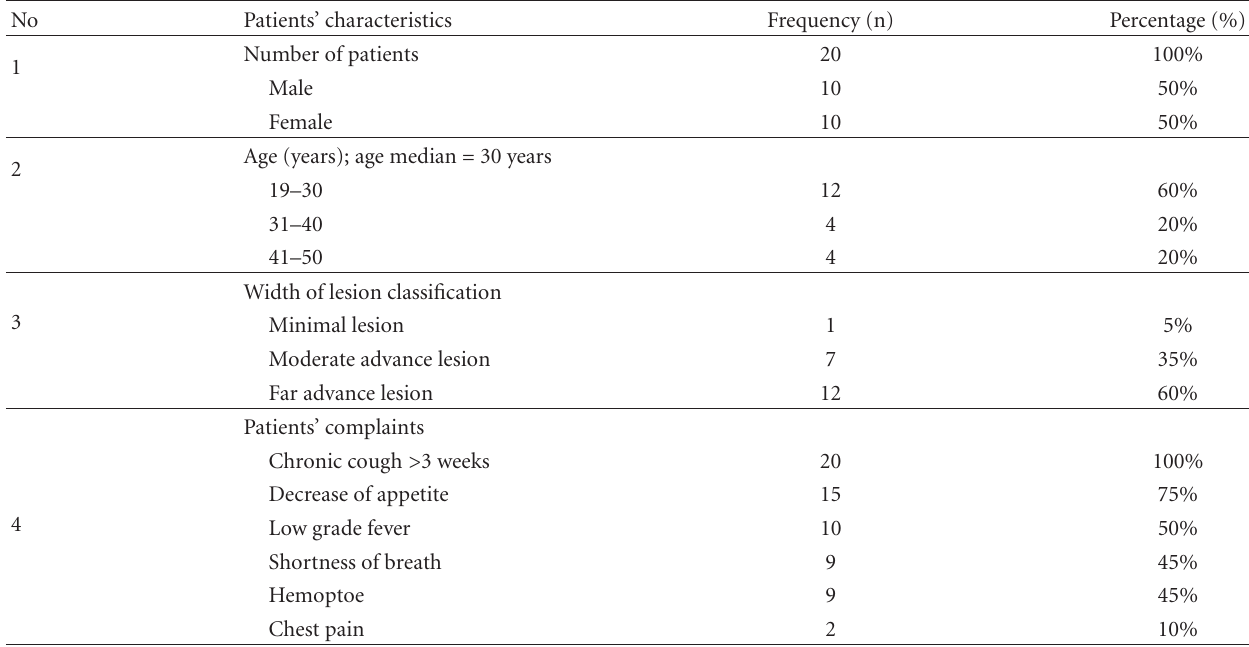
Table 1: Clinical data of patients included in the study.